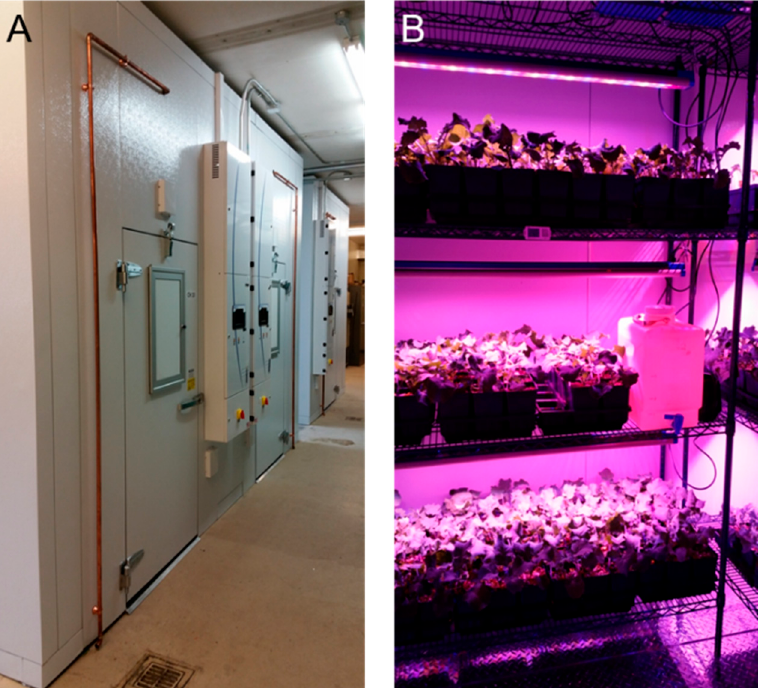
Figure 1. Custom made vernalization and freezing chambers. ( A ) Vernalization chamber is a stand-alone room, and the temperature range is +4 °C to +7 °C. Freezing chamber consists of 2-compartment structure with shared center wall, and the temperature range is − 20 °C to +37 °C. ( B ) All chambers were equipped with LED grow lights with an average intensity of 4500 lux at plant